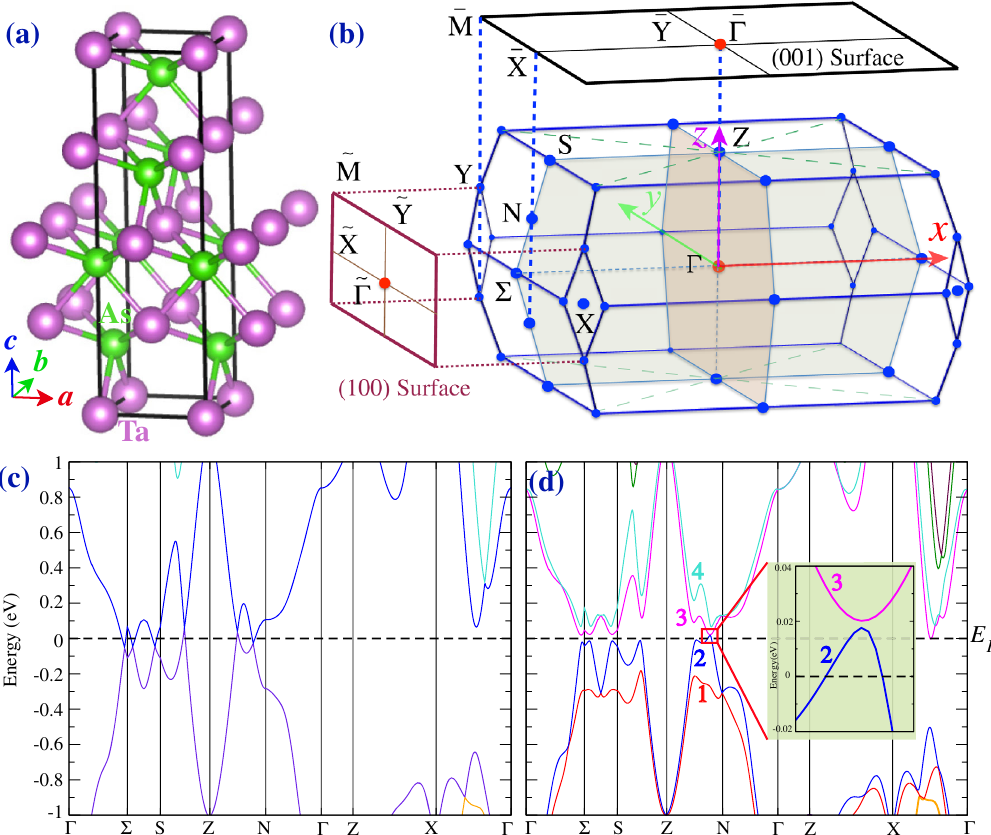
FIG. 1. Crystal structure and Brillouin zone (BZ). (a) The crystal symmetry of TaAs. (b) The bulk BZ and the projected surface BZ for both (001) and (100) surfaces. (c) The band structure of TaAs calculated by GGAwithout including the spin-orbit coupling. (d) The band structure of TaAs calculated by GGA with the spin-orbit